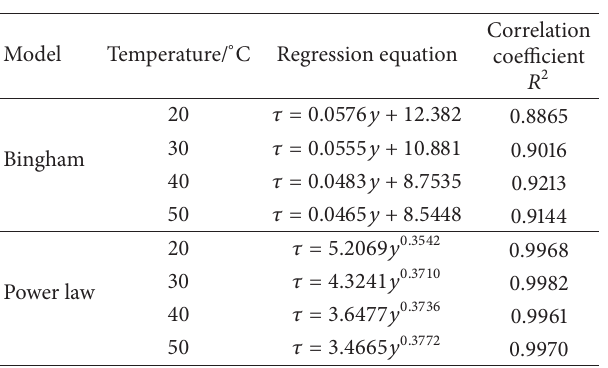
Table 3: Applicable formula and correlation coefficient of different drilling fluid rheological models under different temperatures.